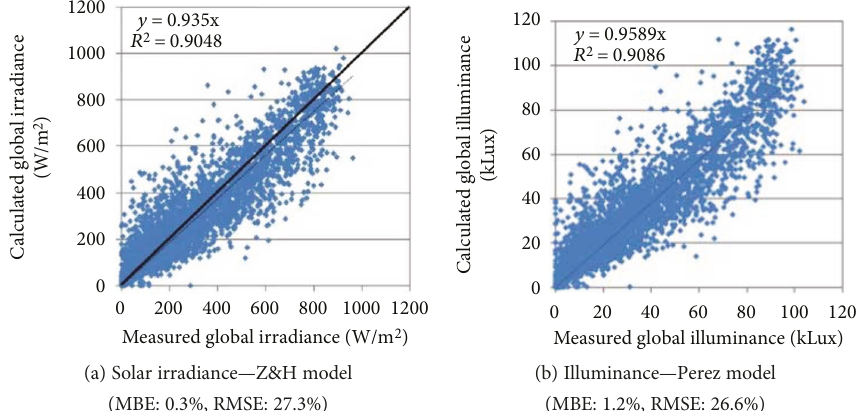
Figure 1: Scatter plotting of global solar radiation and luminous e ffi cacy models performance for Lyon, France